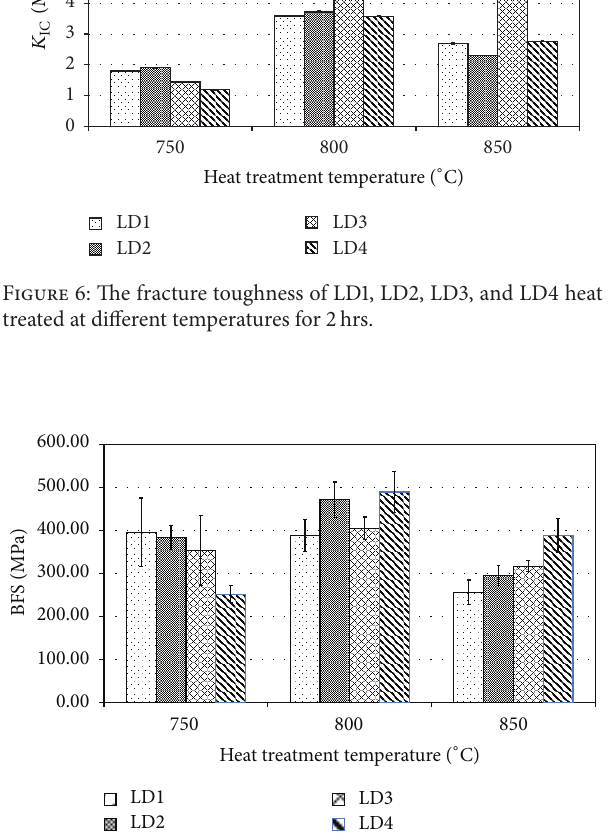
Figure 7: The biaxial flexural strength of LD1, LD2, LD3, and LD4 at different heat-treated temperatures for 2 hrs.